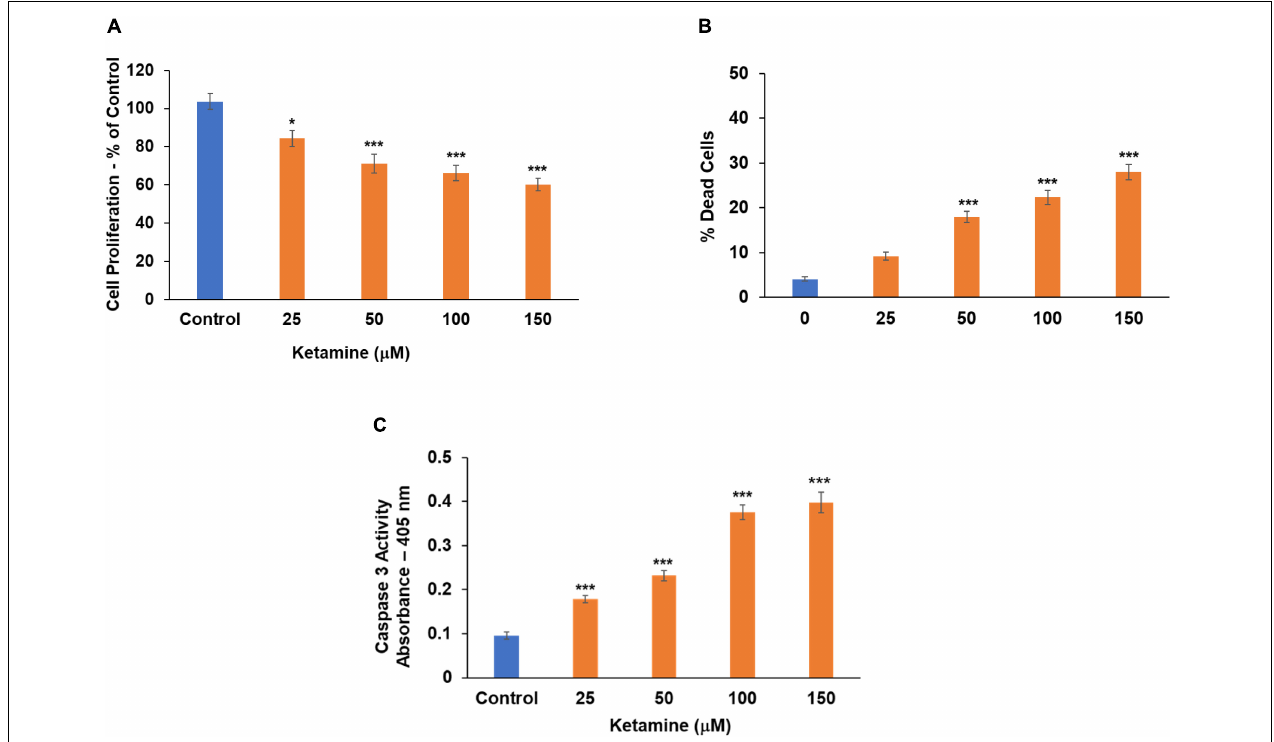
FIGURE 3 | Ketamine inhibits cell proliferation and increases cell death in oligodendrocyte precursor cells. Human oligodendrocyte progenitor cells were treated with ketamine and analyzed 48 h later for cell proliferation (A) and cell death using the live/dead assay (B) and caspase 3 activity (C) . The results are the means ± SD of four independent test analyzed in triplicates. * P < 0.05 and *** P <